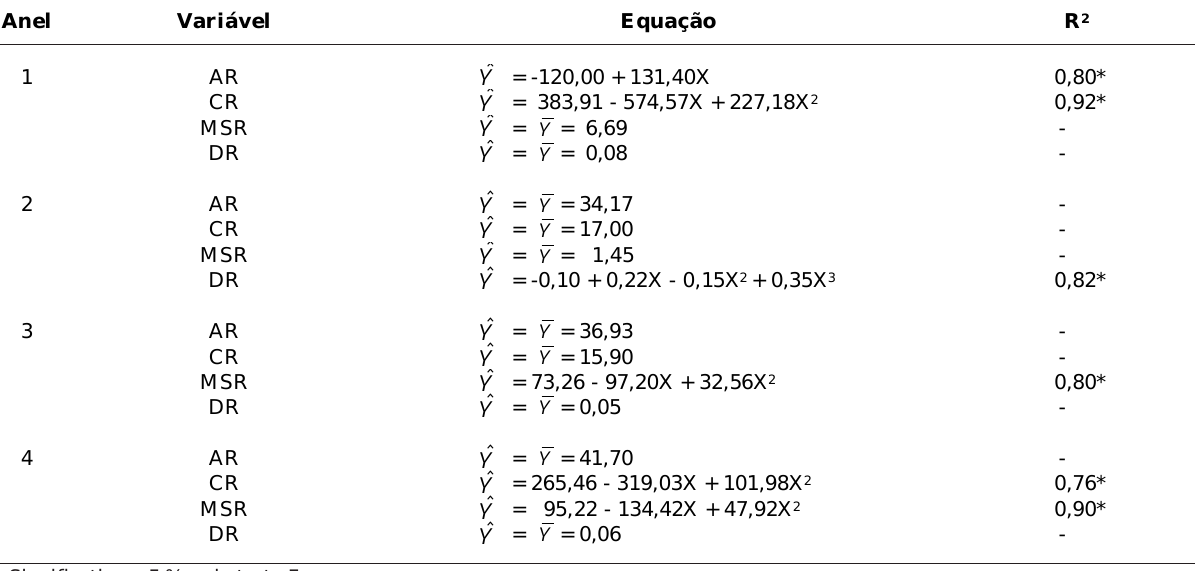
Quadro 6. Equações de regressão ajustadas para área radicular (AR), comprimento de raízes (CR), matéria